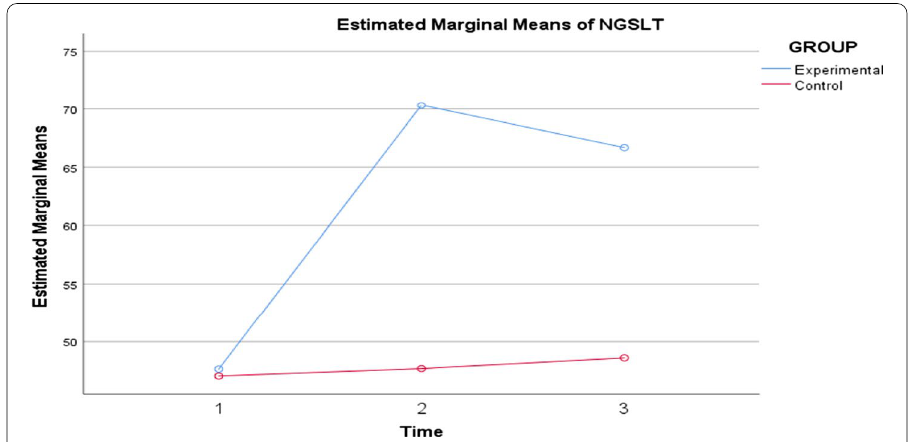
Fig. 3 Plot representing obtained results by participants in three